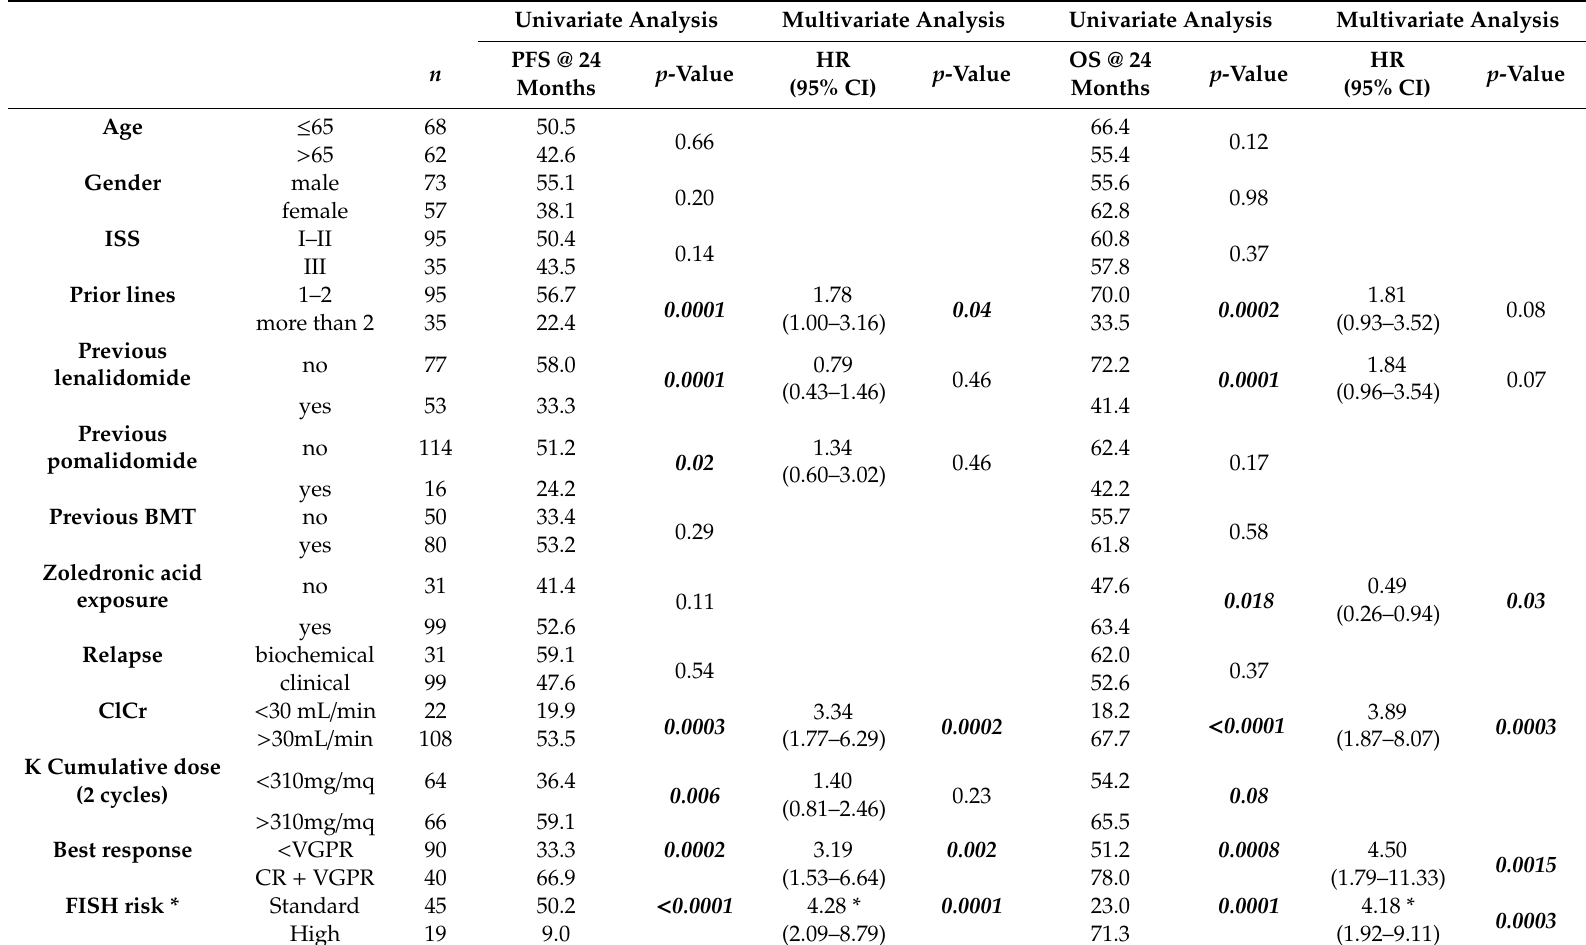
Table 5. Univariate and multivariate analysis of PFS and OS. Univariate